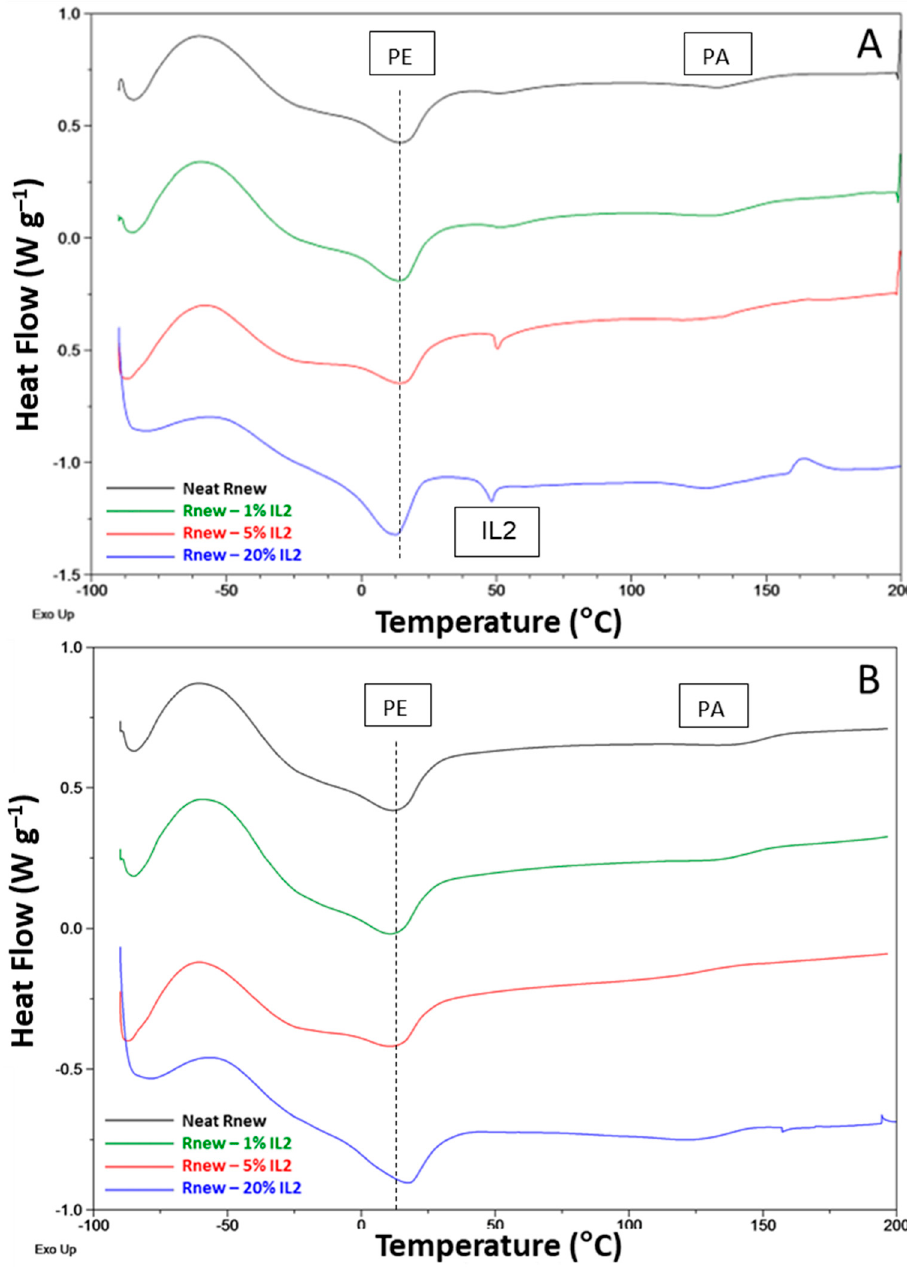
Figure 7. DSC traces for neat Pebax ® Rnew and Pebax ® Rnew–IL2 (OOMmimPF 6 ) composite mem- branes. ( A ) First heating scan; ( B ) Second heating scan.